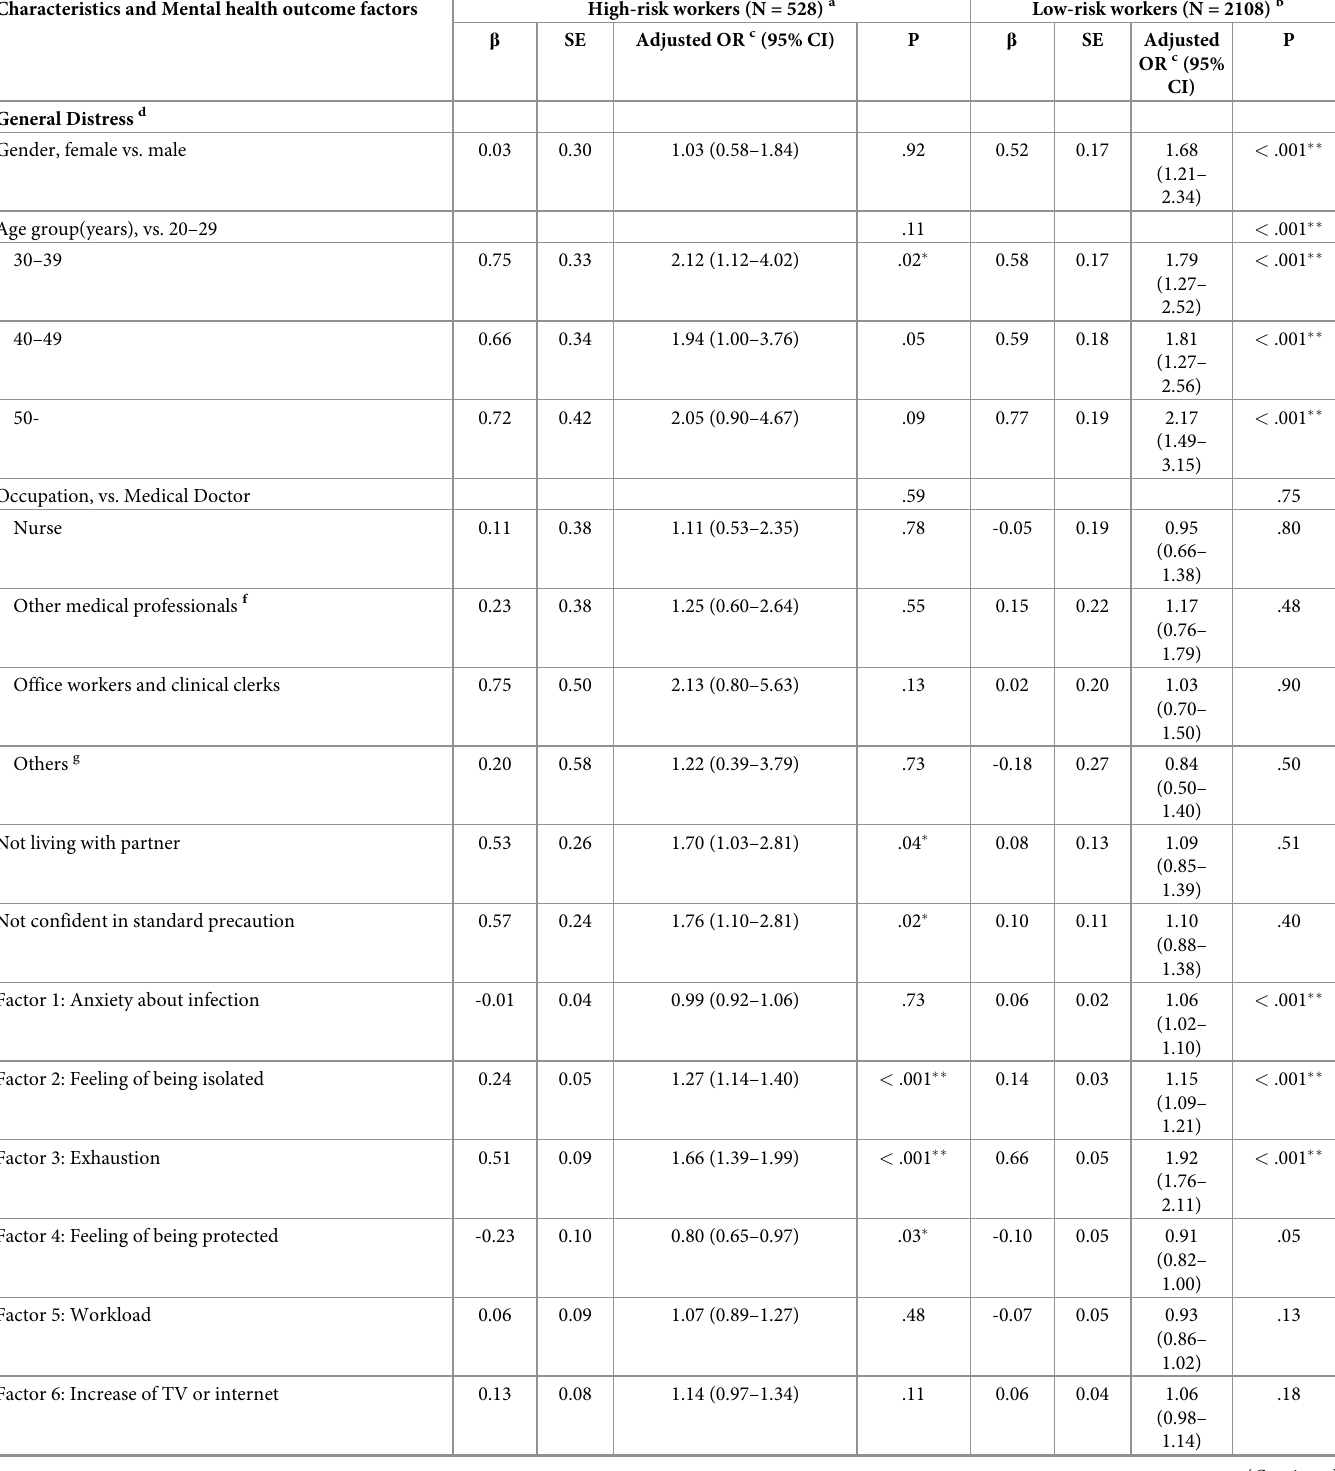
Table 4. Factors associated with general distress and event-related distress identified by multivariable logistic regression analysis. Characteristics and Mental health outcome